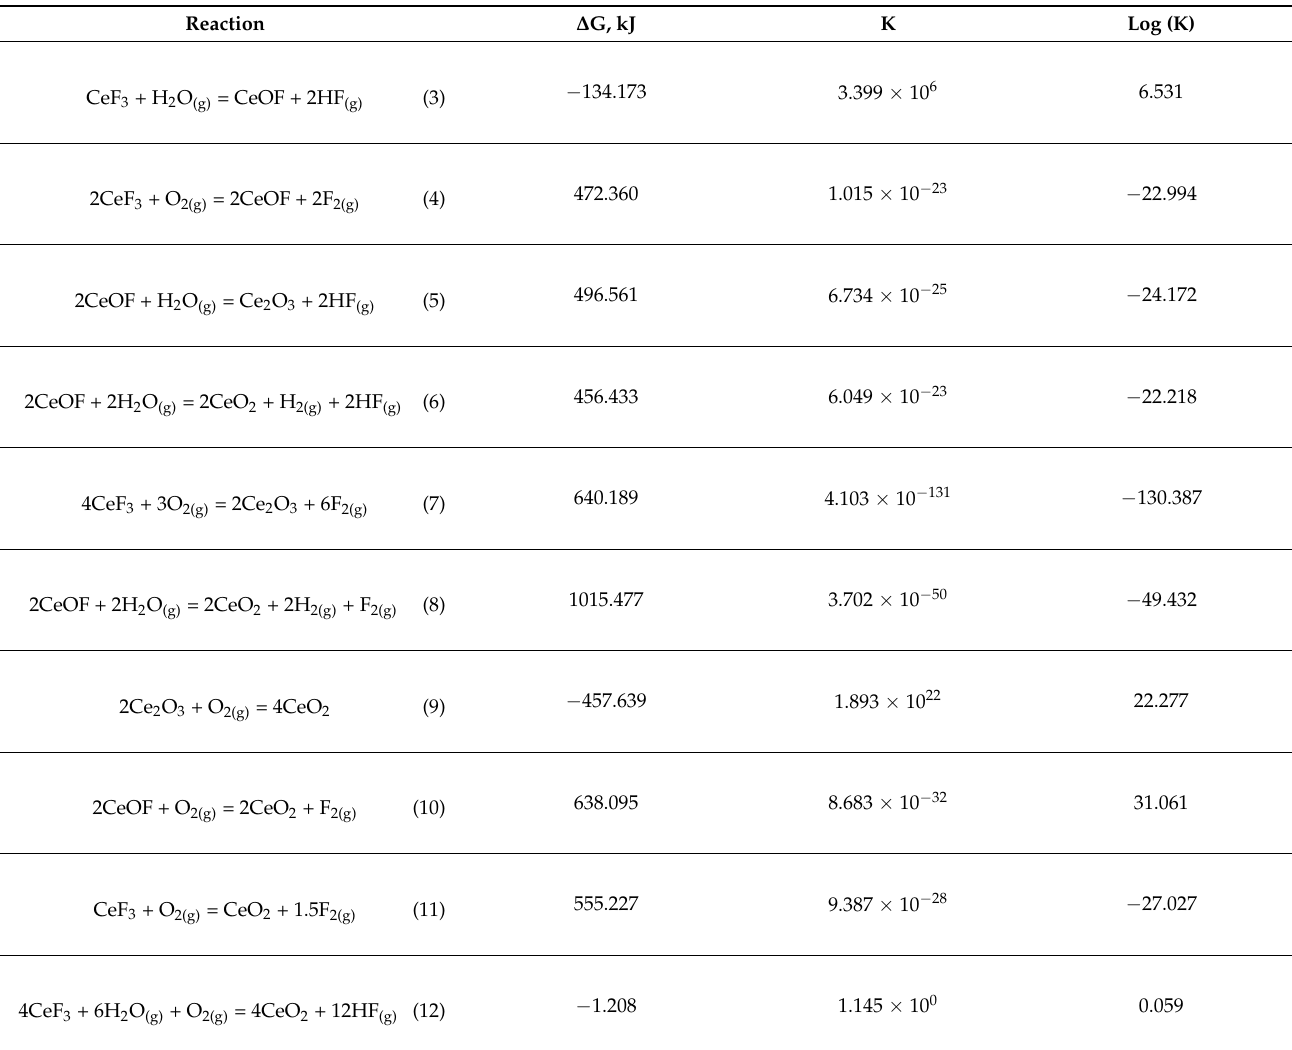
Table 1. Thermodynamic parameters of reactions ( ∆ G denotes the change in Gibbs energy, K is the reaction constant), T = 800 ◦